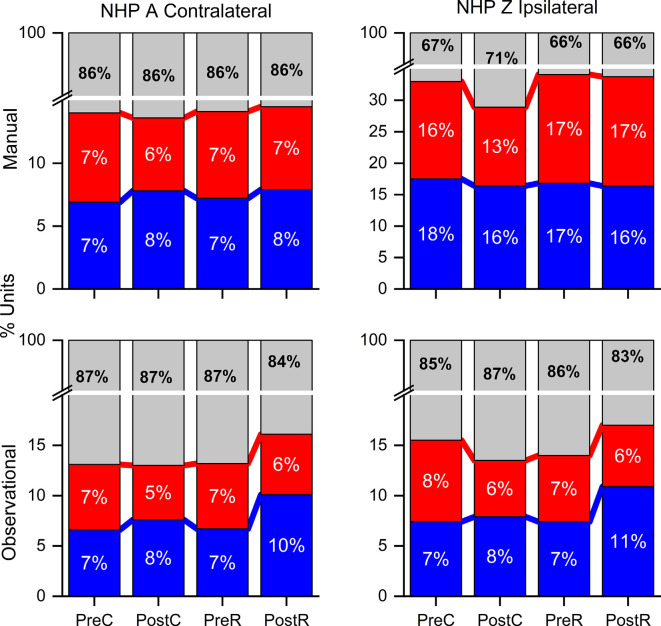
Percent of unit pairs that have higher noise-correlation for R (red), NR (blue), or neither (gray) trial type for both NHPs and tasks as labeled during the pre- and post-cue, pre- and post-result periods. Note the break in the y-axis.